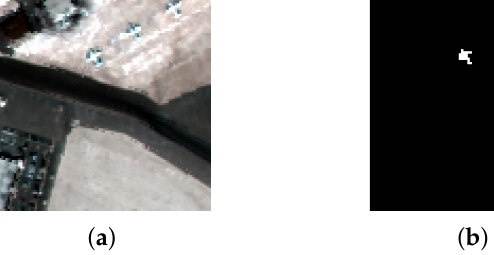
Figure 5. San Diego dataset. ( a ) Pseudo-color image; ( b ) Ground-truth map; ( c ) Spectral curves of mean anomalies and main backgrounds.